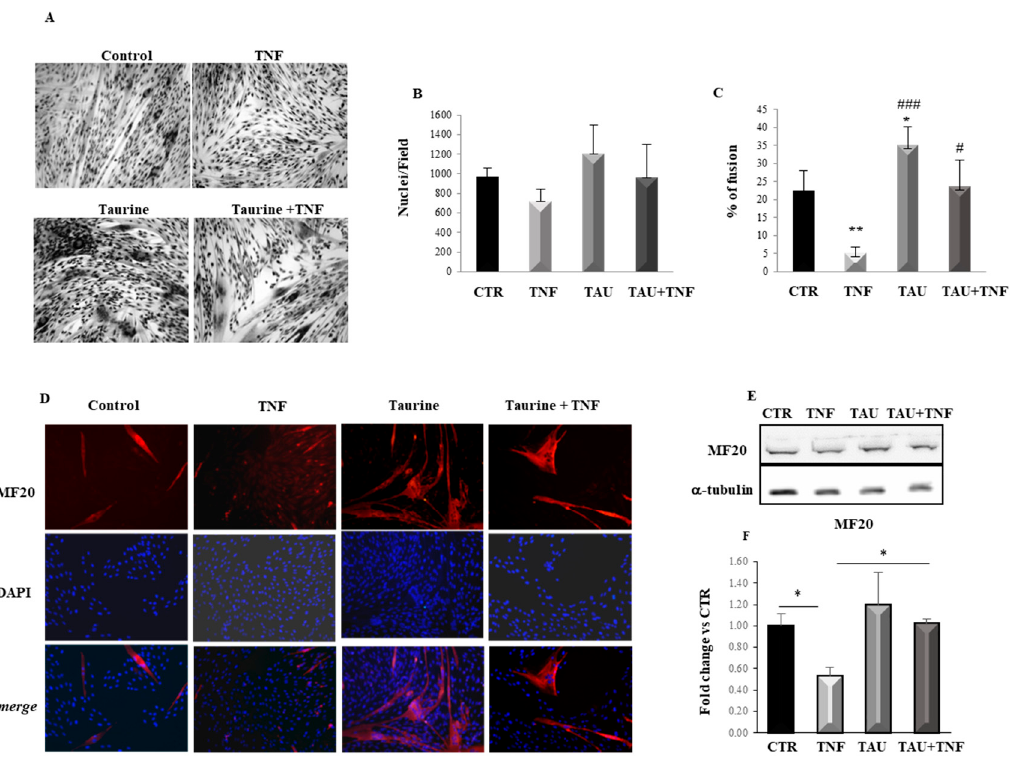
Figure 1. Taurine counteracts the Tumor Necrosis Factor α (TNF)-dependent effect on myogenic differentiation. ( A ) Morphological analysis of L6 cell differentiation evaluated by May-Grunwald Giemsa staining after 7 days of the indicated treatments. ( B ) Diagram showing the total number of nuclei (fused and unfused) per microscopic field in control, TNF-, taurine-, and TNF + taurine-treated cells. ( C ) Diagram showing the ratio between the numbers of nuclei present in myotubes versus the total number of nuclei per microscopic field, expressed as the percentage of fusion. Each experimental point represented in the graphs is the mean ± SD of the counts from three independent experiments. ( D ) Immunofluorescence analysis of L6 cells shows Myosin Heavy Chain (MHC) (MF20) expression in the cultures treated as described above (original magnification × 20). ( E ) Western Blotting of the MHC (MF20) expression performed after 3 days of the indicated treatments. A representative blot is shown. ( F ) Densitometric analyses performed by using anti-alpha-tubulin antibody to verify equal loading of the samples. Statistical analysis was performed using Student’s t -test *# p < 0.05; ** p < 0.01; ### p < 0.001. For Figure 1C * vs. Control, # vs. TNF.